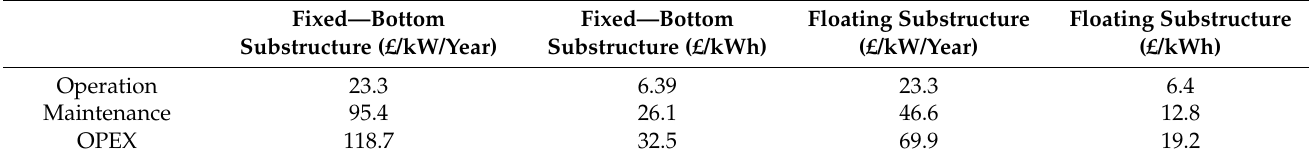
Table 8. Fixed and Floating Parameter Valuations [17].